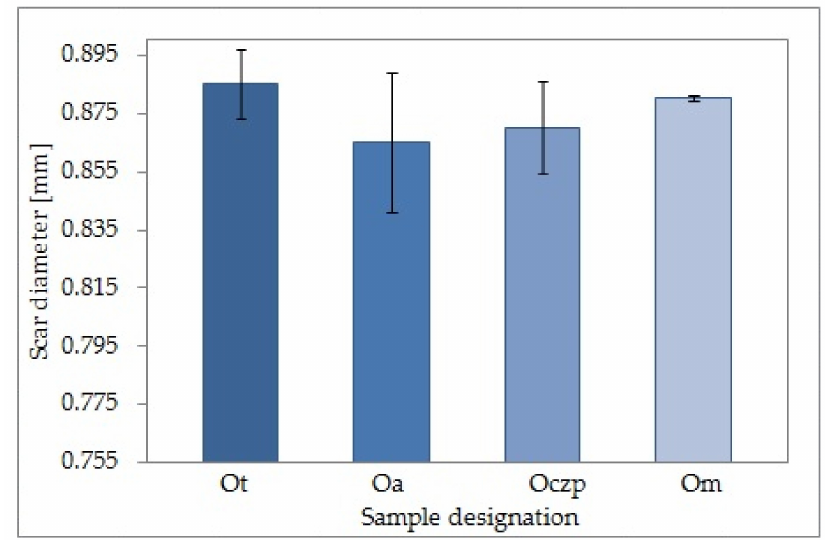
Figure 3. Scar diameters for the tested oils. Ot = strawberry seed oil, Oa = chokeberry seed oil, Oczp = black currant seed oil and Om = raspberry seed